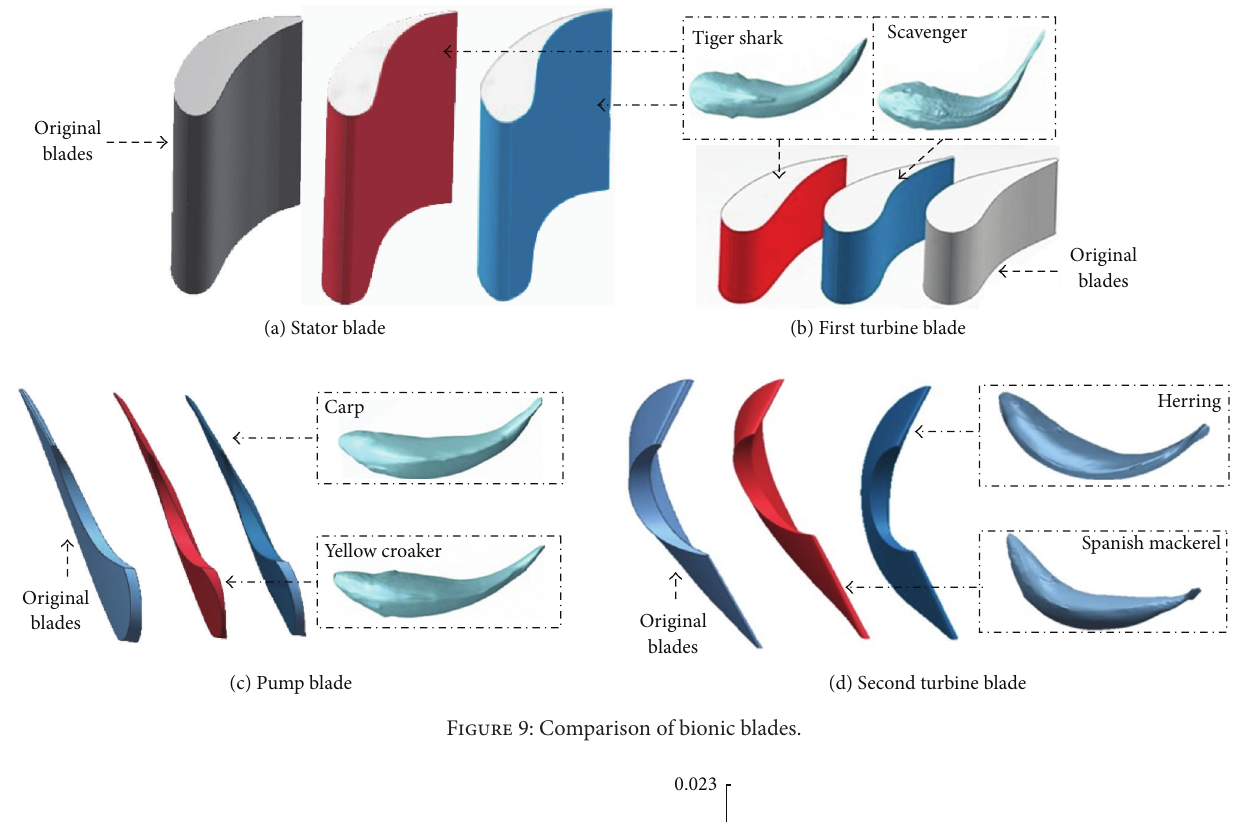
Figure 9: Comparison of bionic blades.